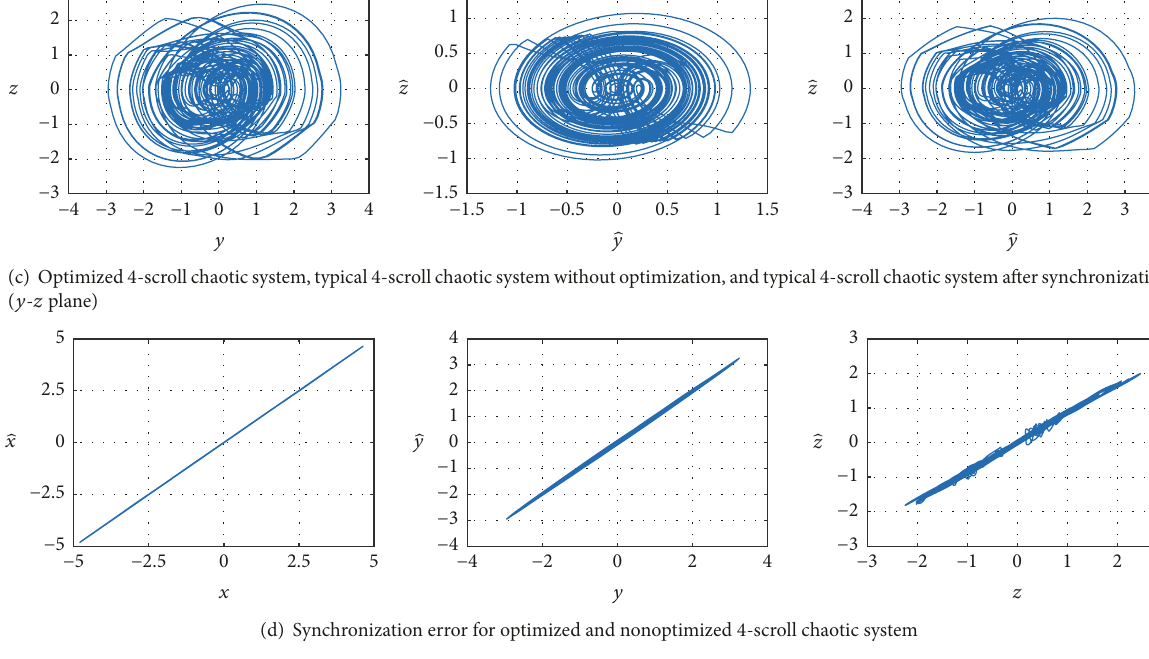
In Figure 14(a) the phase portraits for master system and slave system without and with synchronization are